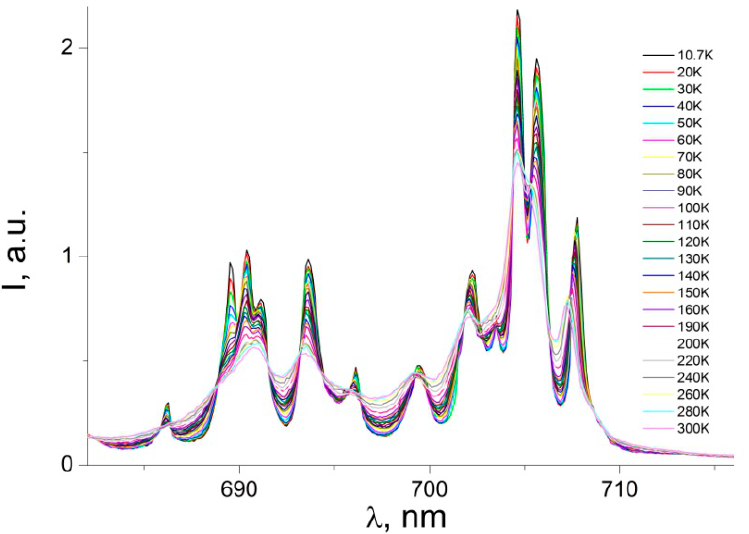
Figure 9. Photoluminescence emission spectra of the powder sample [Eu( µ 2 - OC 2 H 5 )(btfa)(NO 3 )(phen)] 2 phen complex: 5 D 0 → 7 F 3 transition.